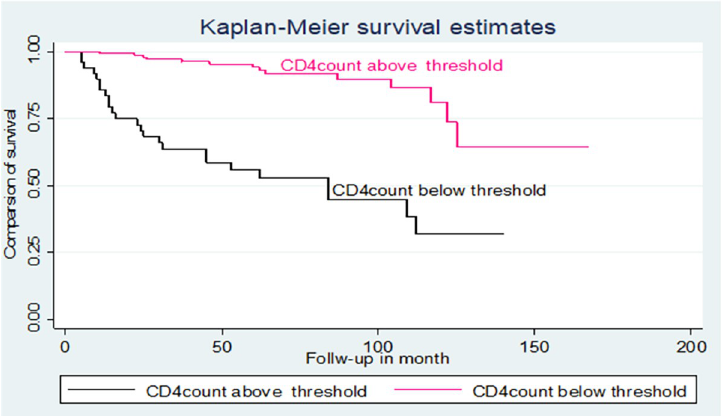
Fig 3. Kaplan-Meier of survival curve of among TB and HIV co-infected children by CD4 counts below the threshold level in northwest Ethiopia hospitals, 2021.